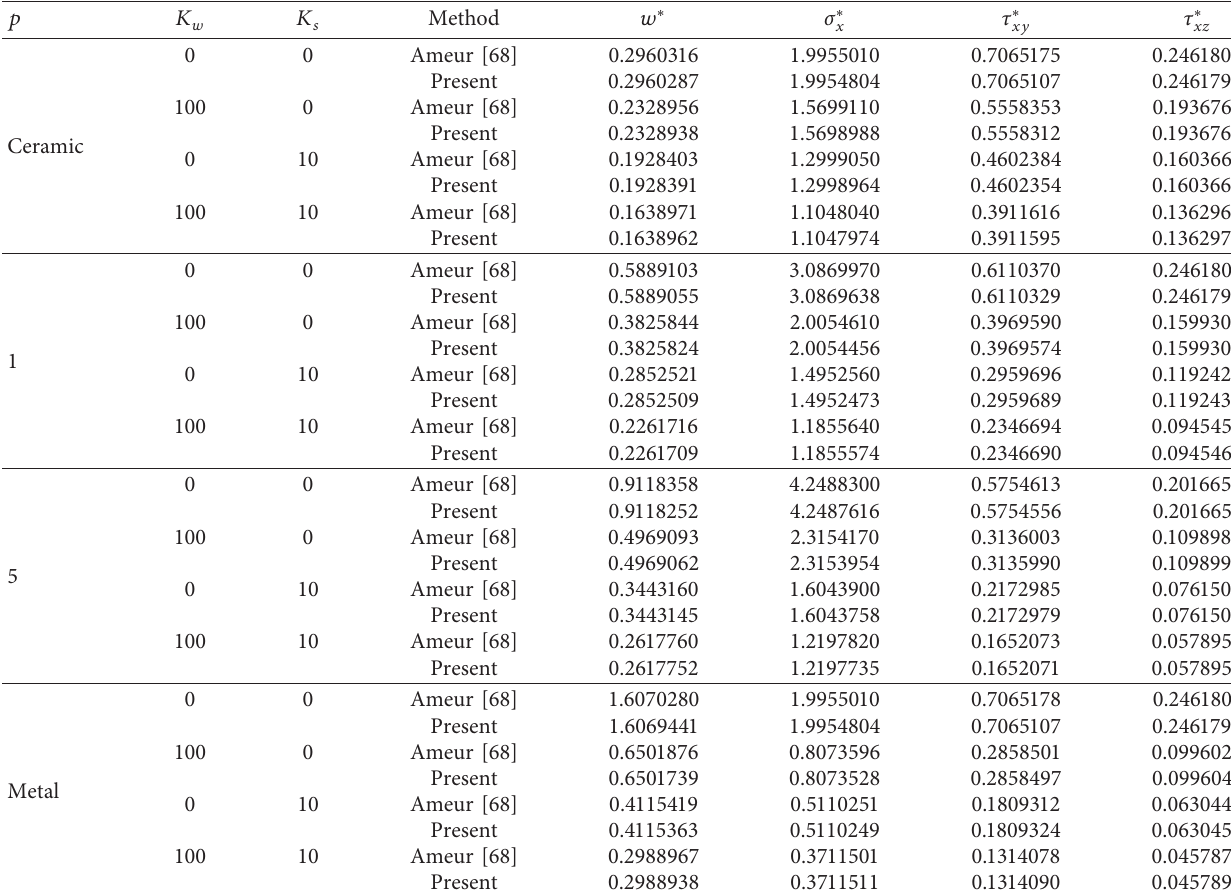
Table 3: The deflections and stresses of the square FGM plates with different values of the power-law exponent.